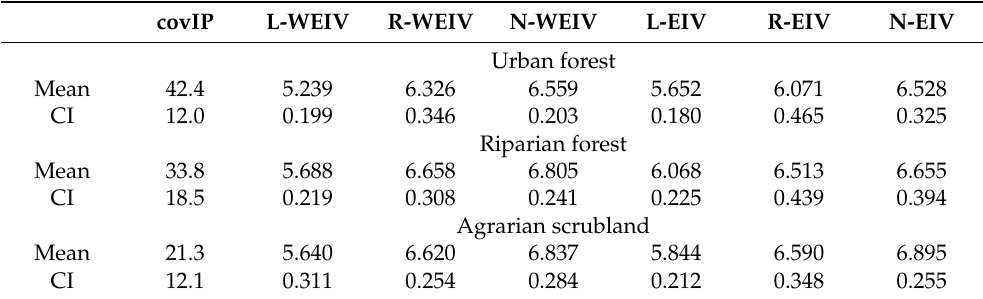
Table 4. Mean values with the interval of confidence (CI) for coverage by I. parviflora (covIP) and of weighted (WEIV) and unweighted Ellenberg indicatory values (EIV) for light (L-WEIV, U-EIV), soil acidity (R-WEIV, U-EIV), and soil nutrients (N-WEIV, N-EIV) per populations group for each biotope (urban forest, riparian forest, and agrarian scrubland). covIP L-WEIV R-WEIV N-WEIV L-EIV R-EIV N-EIV Urban forest Mean 42.4 5.239 6.326 6.559 5.652 6.071 CI 12.0 0.199 0.346